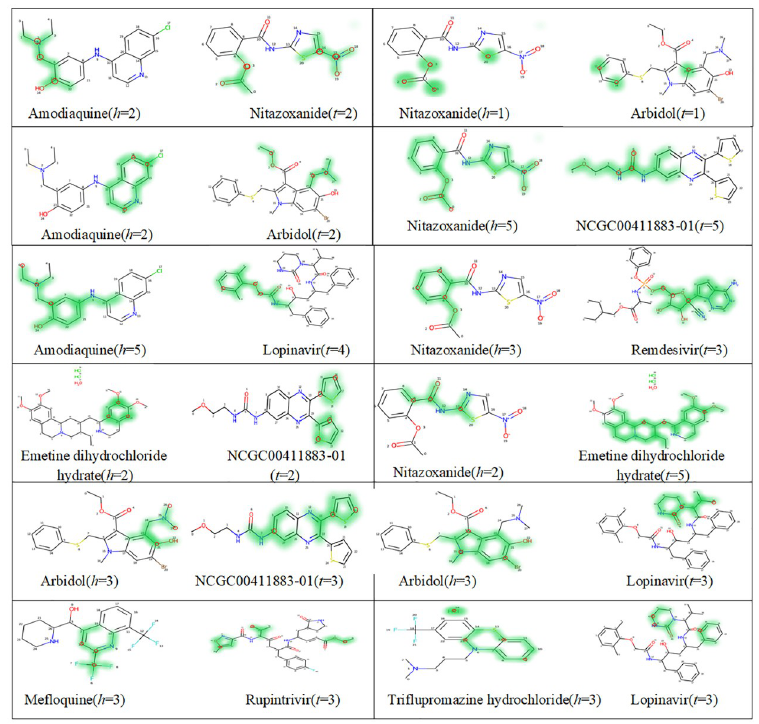
Fig 10. The key substructures contributing to the SARS-CoV-2 drug combinations. The center of the most important substructure and its receptive field are shown as red circle and green colors respectively.